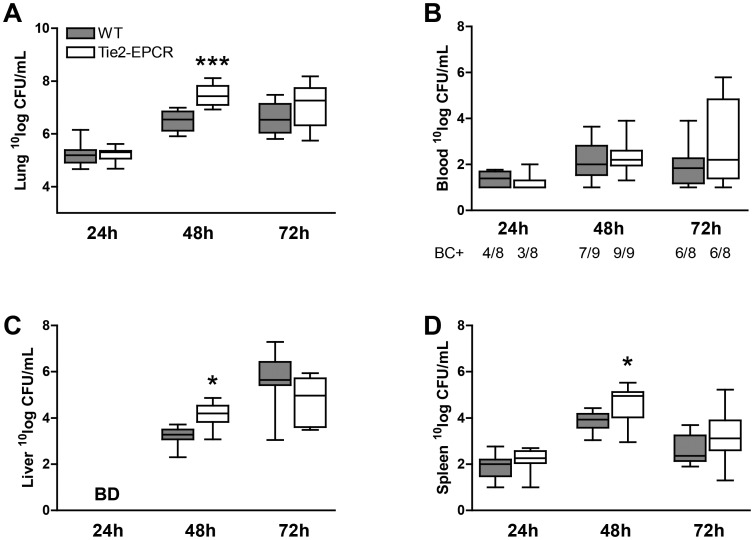
Overexpression of EPCR facilitates bacterial growth and dissemination.Mice were inoculated with 300 CFU of B. pseudomallei and sacrificed after 24, 48 and 72 hours. Bacterial loads were determined in lung homogenates (A), blood (B), liver homogenates (C) and spleen homogenates (D). Data are expressed as box and whisker plots showing the smallest observation, lower quartile, median, upper quartile and largest observation. Grey boxes represent WT mice, white boxes represent Tie2-EPCR mice (n = 8–9 mice per group for each time point). *P<0.05 and **P<0.01 for WT versus Tie2-EPCR mice (Mann-Whitney U test).